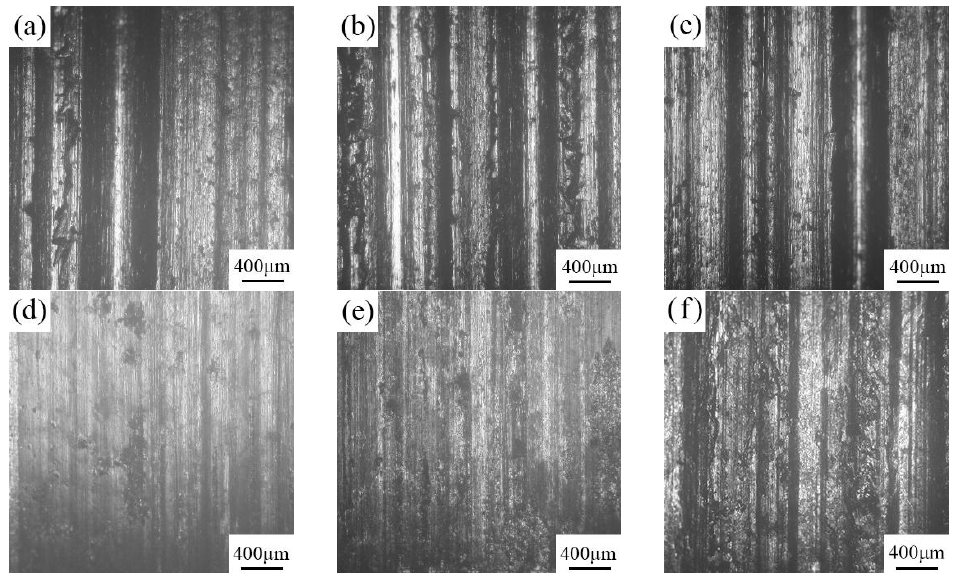
Figure 5. Two-dimensional friction surface morphology of aluminum bronze ( a – c ) and aluminum bronze-based ISSLB materials ( d – f ), ( a , d ) 100 N, ( b , e ) 300 N, ( c , f ) 500 N.